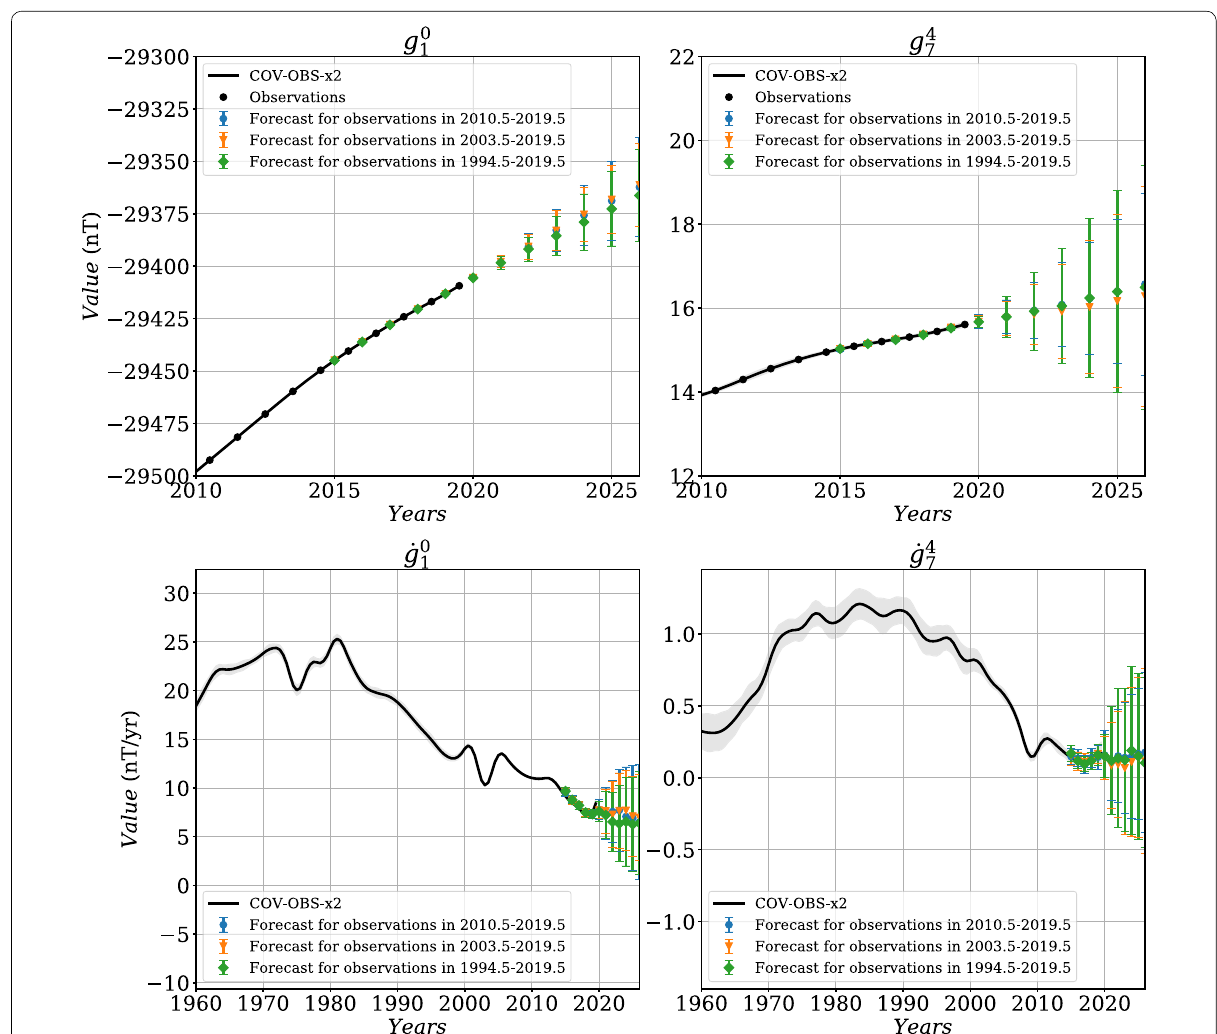
Fig. 7 5-years forecasts using and (cid:31) t o = 1 year, for different observation periods, compared with COV-OBS.x2 in black (with in gray-shaded area the associated ± σ uncertainties), for the MF (top) and the associated SV (bottom) of Gauss coefficients g 0 1 (left) and g 4 7 (right). Errorbars represent the dispersion ( ± σ ) with the ensemble of